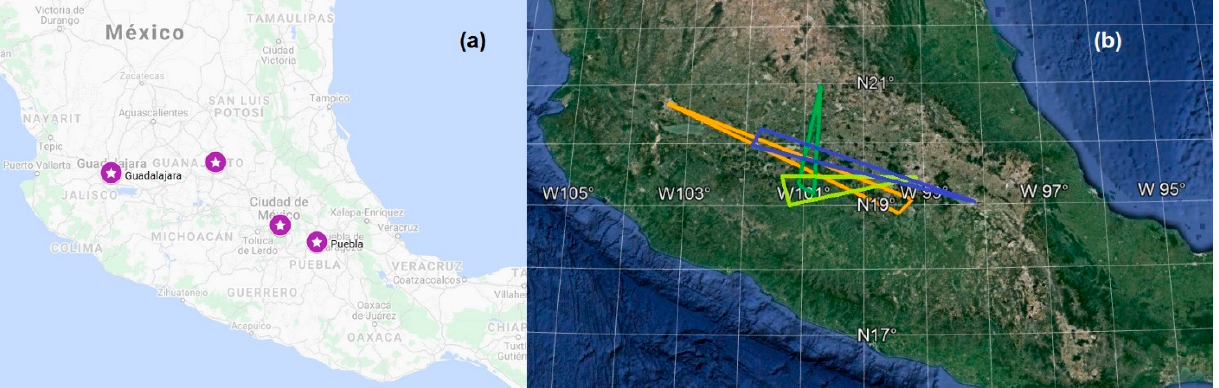
Figure 3. ( a ) Cameras locations; ( b ) planes of the apparent meteor trajectory for each camera. First, known object sizes were used (buildings, streets, landscape marks, etc.) to estimate the field of view, azimuth and the height of the cameras. Further, the planes of the apparent meteor trajectory for each camera were plotted. Figure 3b shows these planes represented by imaginary triangles and their intersection. The length of each triangle